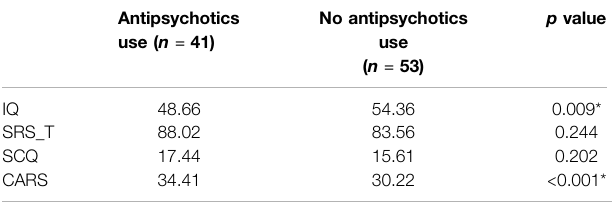
TABLE 2 | Differences in clinical scores between ASD children with and without antipsychotics use. Antipsychotics use ( n = 41)